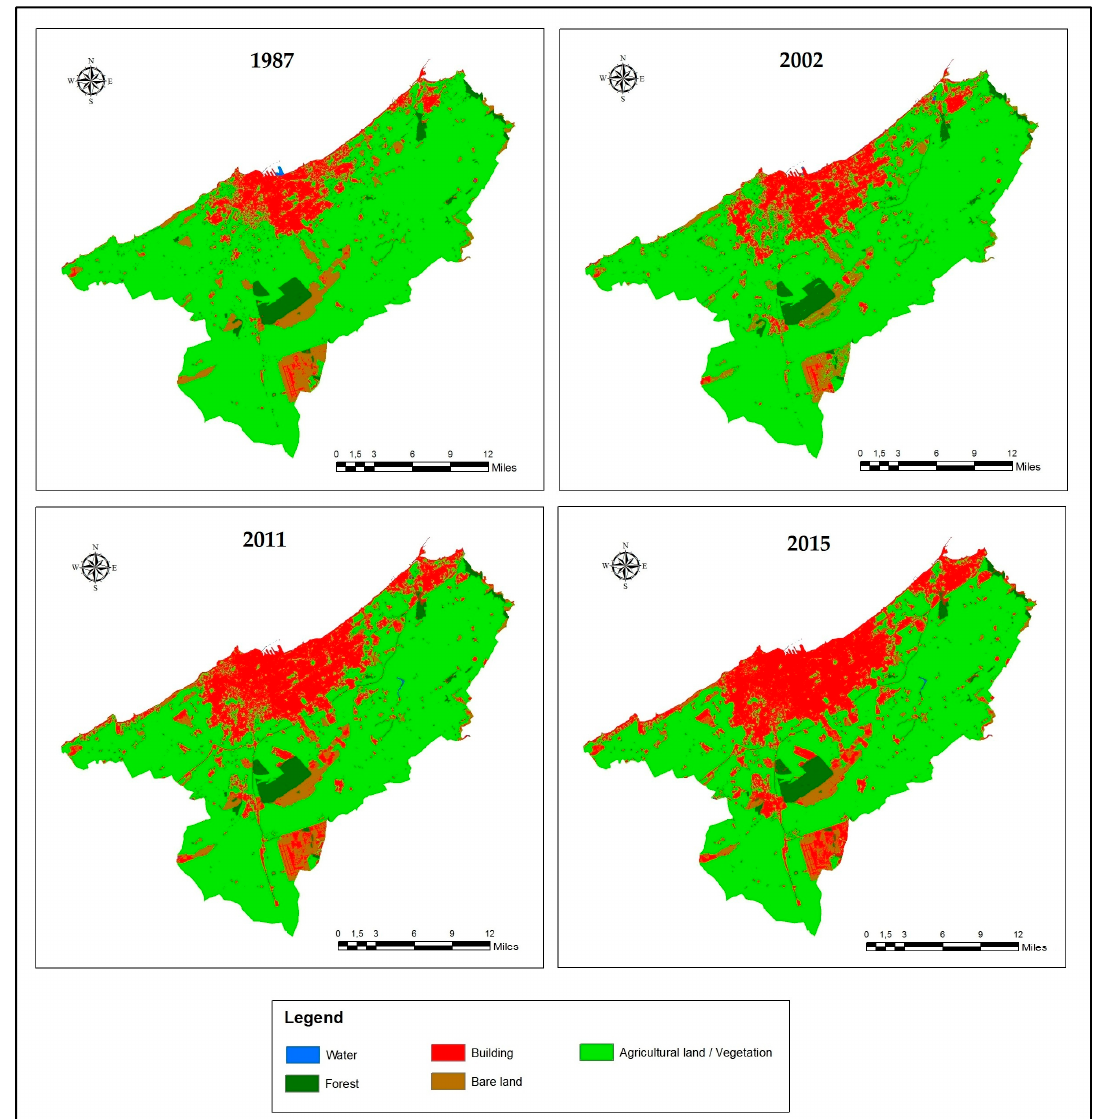
Figure 6. Land cover classification of Casablanca region from 1987 to 2015.